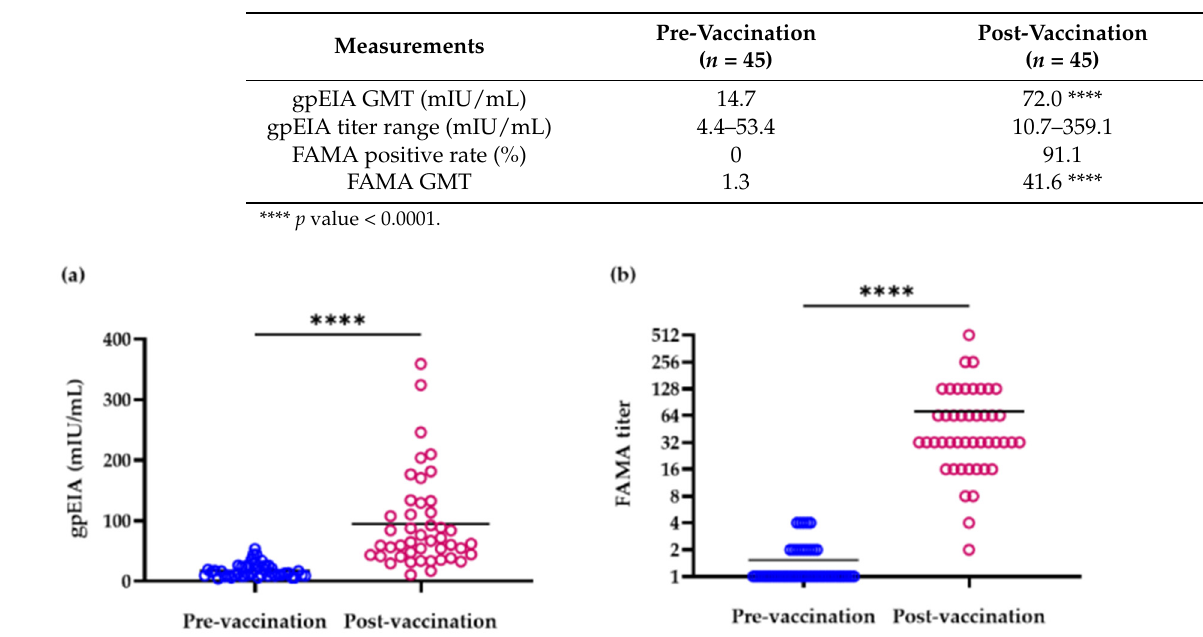
Figure 1. Distribution of gpEIA antibody titers ( a ) and FAMA titers ( b ) in pre- and post-vaccination paired sera. **** p value < 0.0001, bar represents mean.